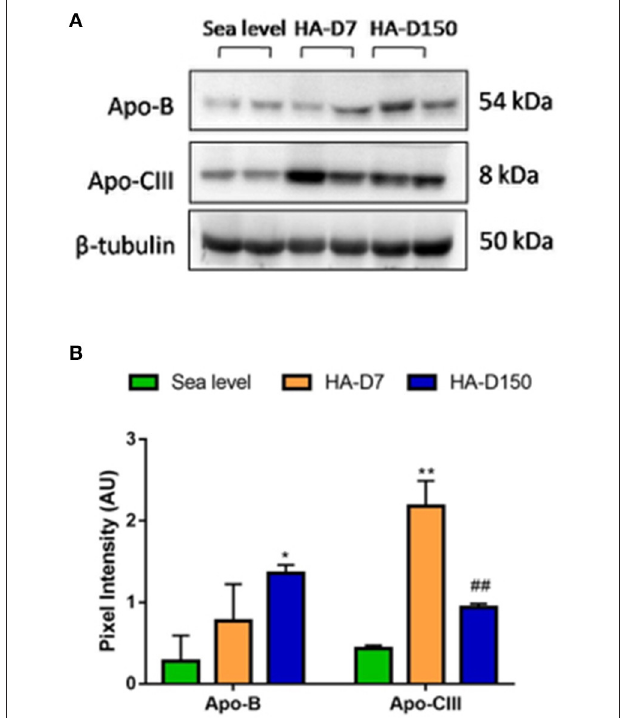
FIGURE 2 | Validation of plasma proteomics data ( n = 6). (A) Western blot analysis of Apo-B and Apo-CIII along with tubulin as a loading control. (B) Densitometry analysis of Apo-B and Apo-CIII with respect to tubulin. *represents p < 0.05, **represents p < 0.01 with respect to sea level and ## represents p < 0.01 with respect to